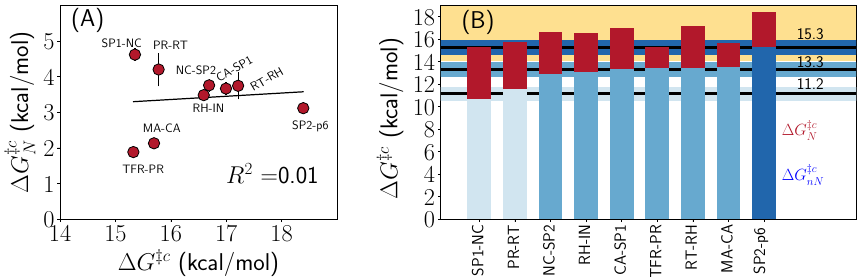
Figure 6. ( A ) Plot of experimentally derived values for the activation barrier ( ∆ G ‡ c ) against calculated values for the free energy of NAC formation in the catalyzed reaction ( ∆ G ‡ c ). ( B ) Comparison of N NAC (red), ∆ G ‡ c , and non-NAC (blue), ∆ G ‡ c , free energy contributions. All systems lie within one of N nN three distinct ∆ G ‡ c bands separated by significantly more than thermal noise (black lines with blue nN bands). Only one non-NAC band is immediately within the virologically relevant region (yellow) for differential enzyme specificity. NAC contributions are small (< 5 kcal/mol) and within 3 kcal/mol of ∼ each other, but serve to fine-tune ∆ G ‡ c for all substrates to both match the optimal barrier differences and reach the relevant barrier region required by the virus—neither of which is achieved, in general, by non-NAC contributions